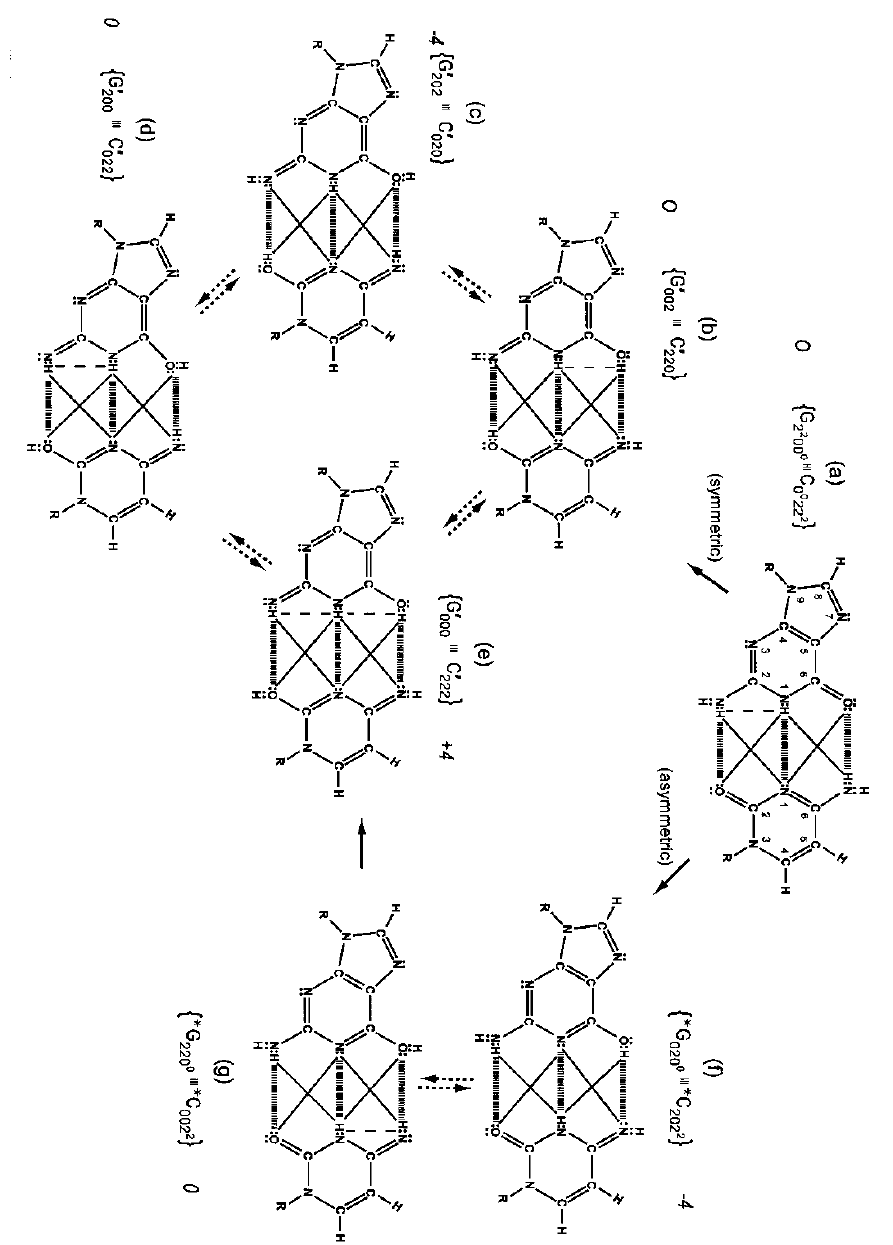
Figure 6 . Qualitative representation of more abundant and less abundant coherent G-C